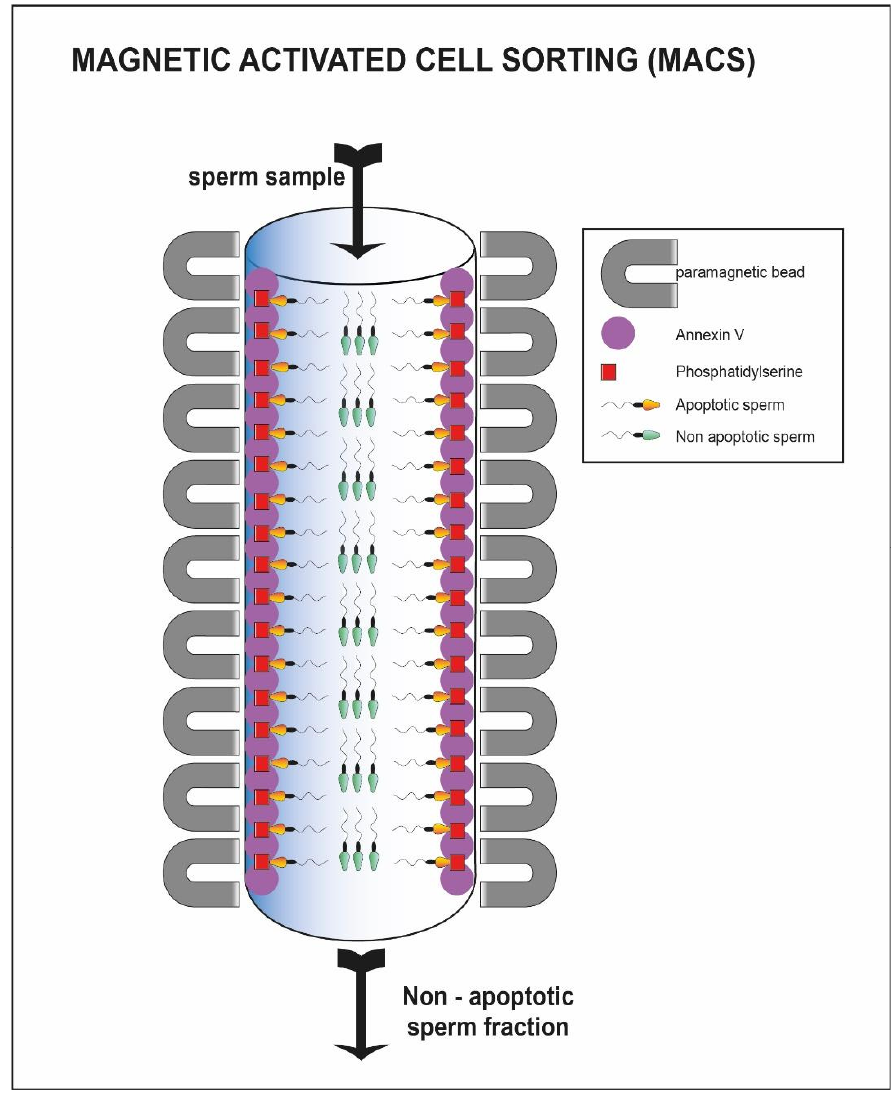
Figure 7. Sperm cell passing through column with annexin V. The sperm cells able to pass through the column represent the viable one (green heads) while the apoptotic fraction remain trapped inside the column (yellow heads).